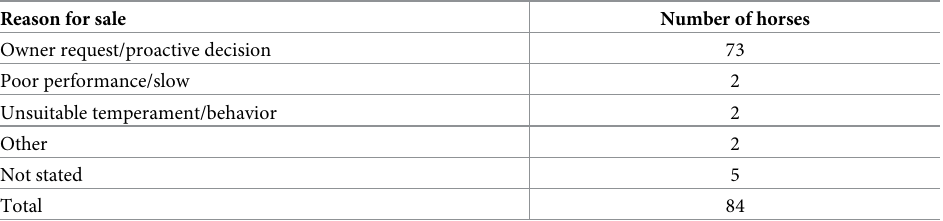
Table 3. Surveyed reasons for the sale of